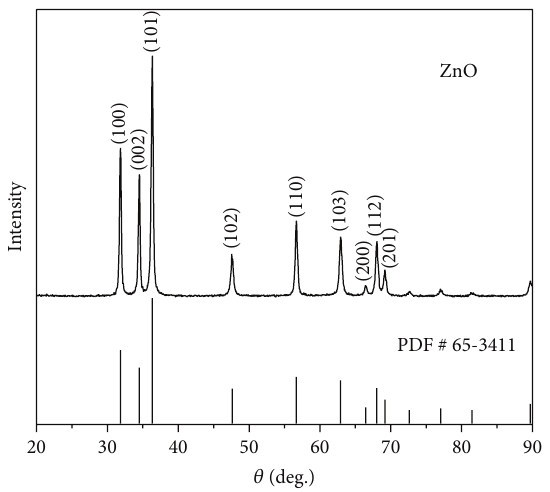
Figure 1: X-ray diffraction pattern of the prepared filter paper inspired zinc oxide